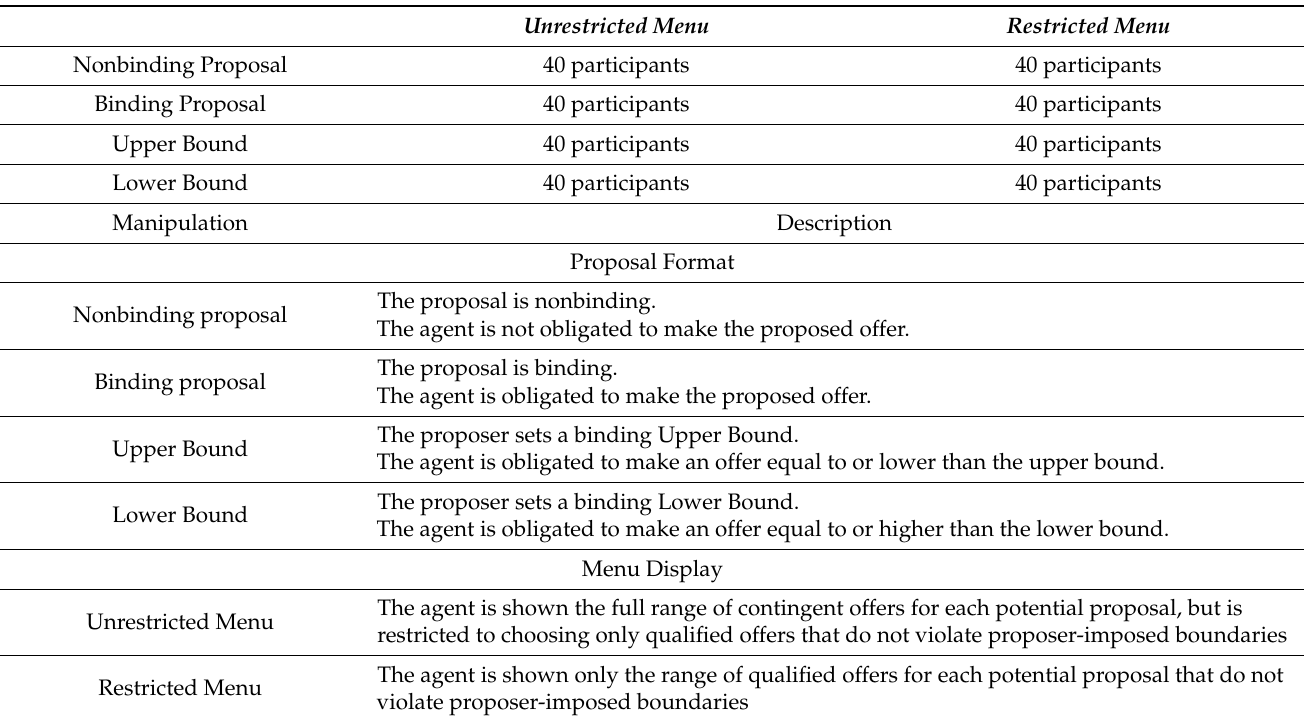
Table 2. The eight conditions of the experimental